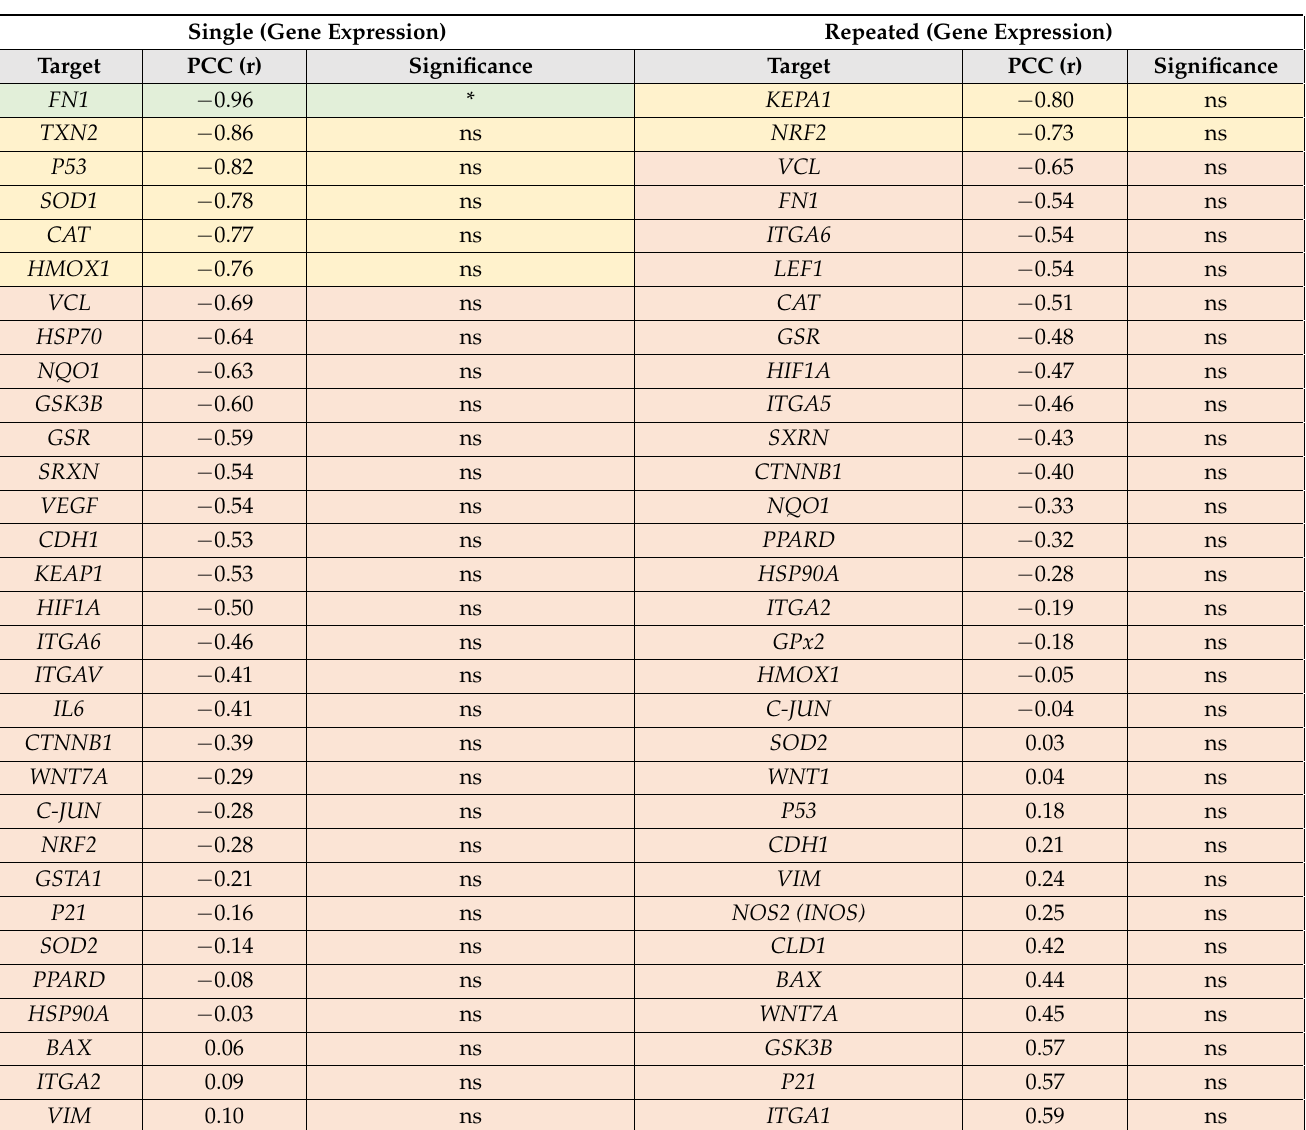
Table 1. Pearson (r) correlation coefficients for several types of analyses for single and repeated NMP effects with the goal of identifying statistical relations between plastic particle sizes and biological effects observed, sorted for descending r-values, showing gene expression after single exposure (top left), gene expression after repeated exposure (top right), protein expression after single (bottom left) repeated (middle bottom right) exposure, and cellular processes (bottom right) such as uptake, metabolic activity, ROS, and thiol content.